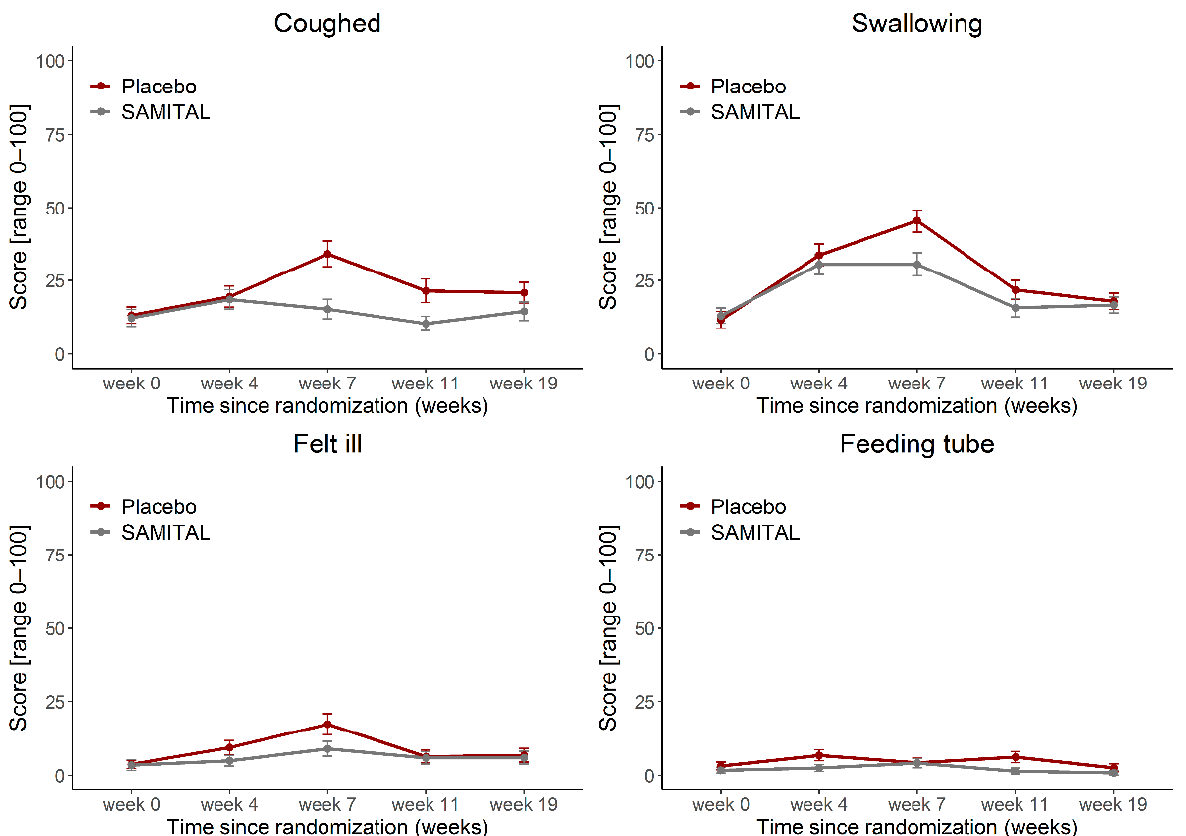
Figure 3. Health-related Quality of Life (HRQoL) scores over time for selected EORTC QLQ-C30 functional scales and EORTC QLQ-H&N35 symptom items/scales. Data are presented as estimated mean HRQoL scores (repeated-measure mixed-effect models) at every time point, together with their 95% confidence intervals. A higher score represents a higher level of functioning or symptoms.